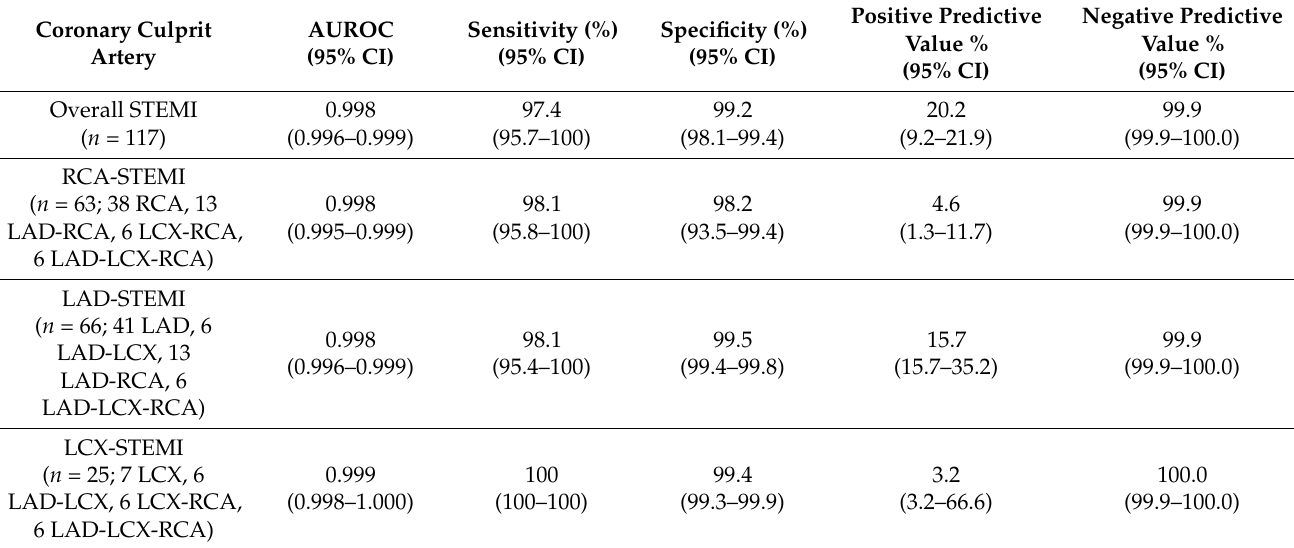
Table 2. Diagnostic accuracy of deep learning model for ST elevation myocardial infarction detection comparing with normal sinus rhythm.